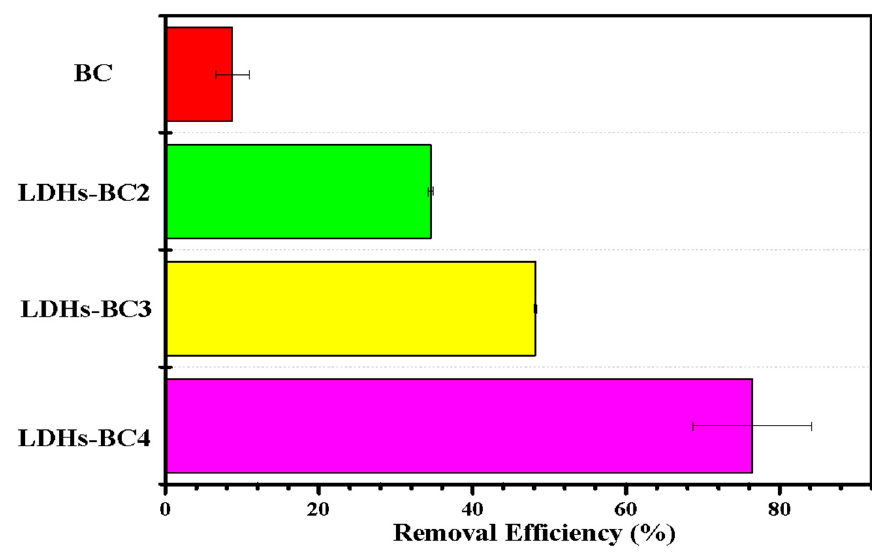
Figure 5. Effect of different materials on phosphate removal.